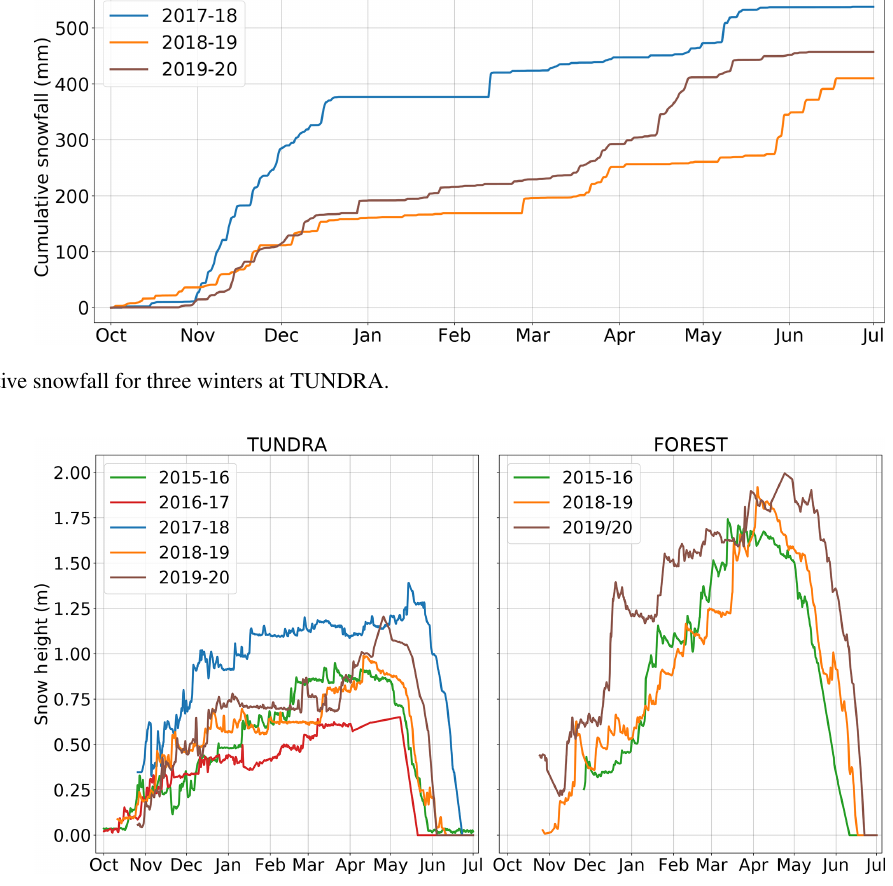
Figure 4. Comparison of the measured snow height of TUNDRA and FOREST for several winters. When necessary, missing data were filled in with time-lapse camera observations of a graduated rod. Unfortunately, there was too much missing data from winters 2016–2017 and 2017–2018 at FOREST, so those winters are not presented here.